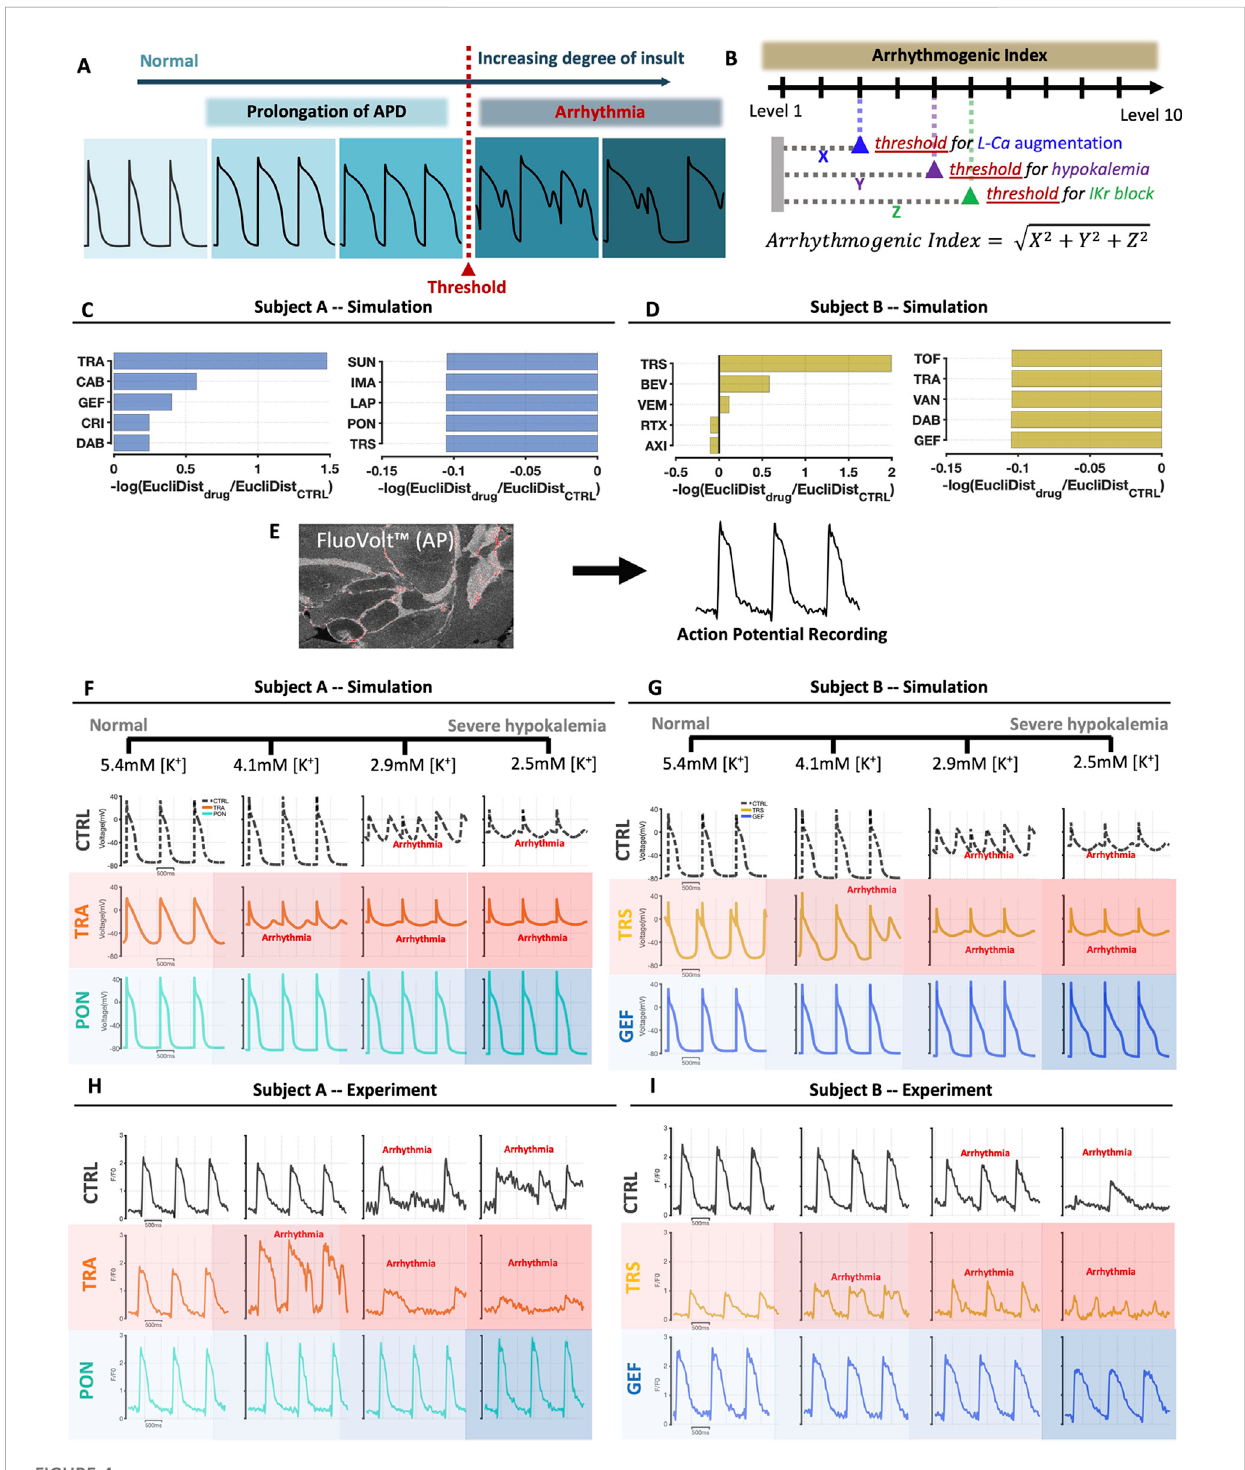
FIGURE 4 Simulations and recordings show that the response of iPSC-CMs to arrhythmogenic secondary insults is drug-speci fi c and cell line-speci fi c. (A) SchematicillustratingthecalculationofiPSC-CMsusceptibilitytosecondaryinsults.Insimulations,thedegreeofinsultisprogressivelyincreased,andthe level at which arrhythmic dynamics such as early afterdepolarizations are seen is taken as the threshold. (B) Arrhythmic index (AI), for each drug and in eachcellline,iscalculatedasaweightedaverageofthresholdvaluesforthreeinsultsapplied,withdatatransformationsappliedsuchthatpositiveAI represents increased susceptibility, and negative AI represents reduced susceptibility. (C, D) Bar graphs show the 5 drugs with the largest and smallest values of AI, in Cell Lines A and B respectively. Note that AI was computed for all 26 drugs tested in the study; results from 16 simulations in each cell line are not shown. (E) Schematic illustrating that APs were recorded in iPSC-CMs loaded with the fl uorescent membrane potential indictor FluoVolt. (F, G) SimulatedAPtracesinCellLinesAandB,respectively,showingresultsinuntreatedcells,incellstreatedwithaTKIpredictedtoincreasesusceptibility,and in cells treated with a TKI predicted to decrease susceptibility. Results are shown atfour differentlevels of hypokalemia, ranging from normal (5.4 mM) to